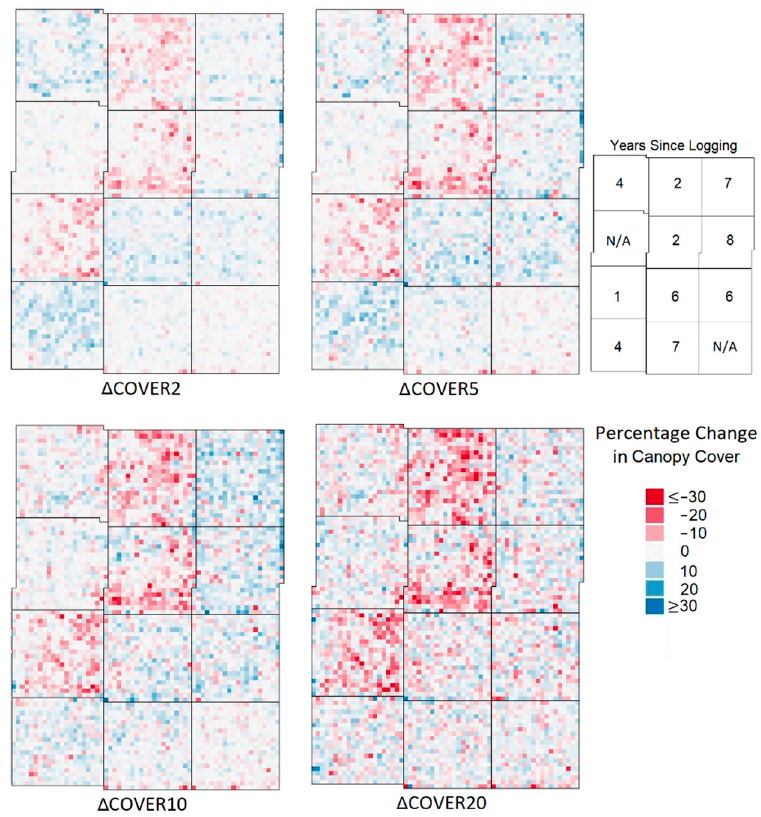
Figure 5. Maps of the percentage change in cover metrics of different height thresholds across the study area between 2012 and 2014 (resolution 50 m). Change is depicted by colour gradient with red representing the greatest negative change and blue the greatest positive change. Δ COVER2, 5, 10, and 20 are the change in percentage cover at height thresholds of 2, 5, 10, and 20 m, respectively.